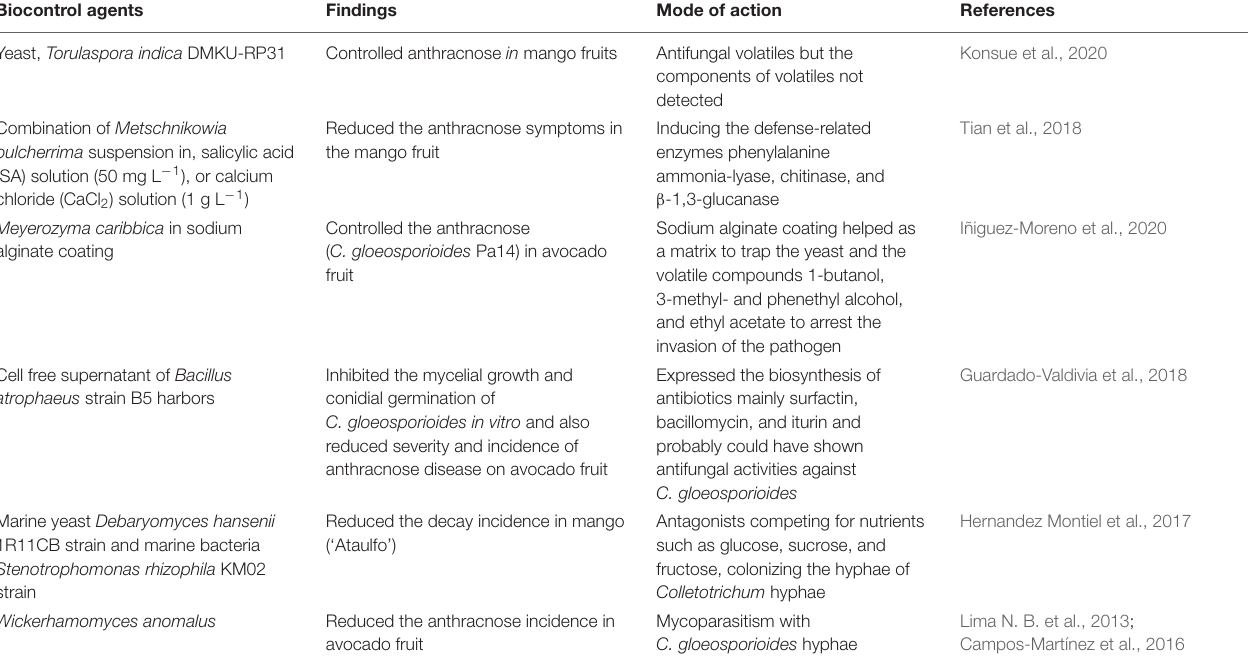
TABLE 4 | Summary of recent developments in biocontrol agent with antifungal properties against Colletotrichum gloeosporioides infecting mango and